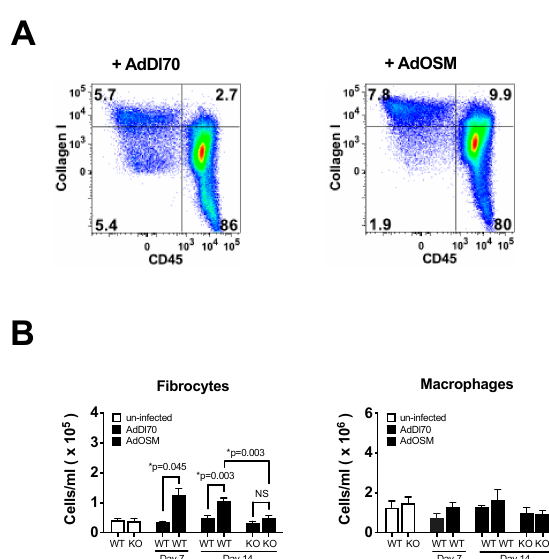
Figure 3. Fibrocyte numbers in AdOSM-treated BALB/c Mouse Lungs. Wildtype BALB/c mice untreated naive mice or wildtype and IL-13-/- (KO) treated mice were endotracheal administered AdDl70 or AdOSM (5 × 10 7 pfu), culled at day 7 or 14, and mononuclear cell suspensions were analyzed by flow cytometry (as described in methods). ( A ) Representative flow cytometry plots showing CD45+col1+ populations (fibrocytes) at day 7 ( B ) CD45+ Collagen 1A1+ Fibrocytes and CD11c- CD11b+ Gr-1- DX5- Macrophage cells from whole lung tissue, after 7 and 14 day treatment, were also quantitated by flow cytometry. Data is shown as the mean +/ − SEM ( n = 5 per group). Statistical significant differences are noted with their p values between the indicated treatment groups. No statistical significance was observed between macrophage numbers in 3B.